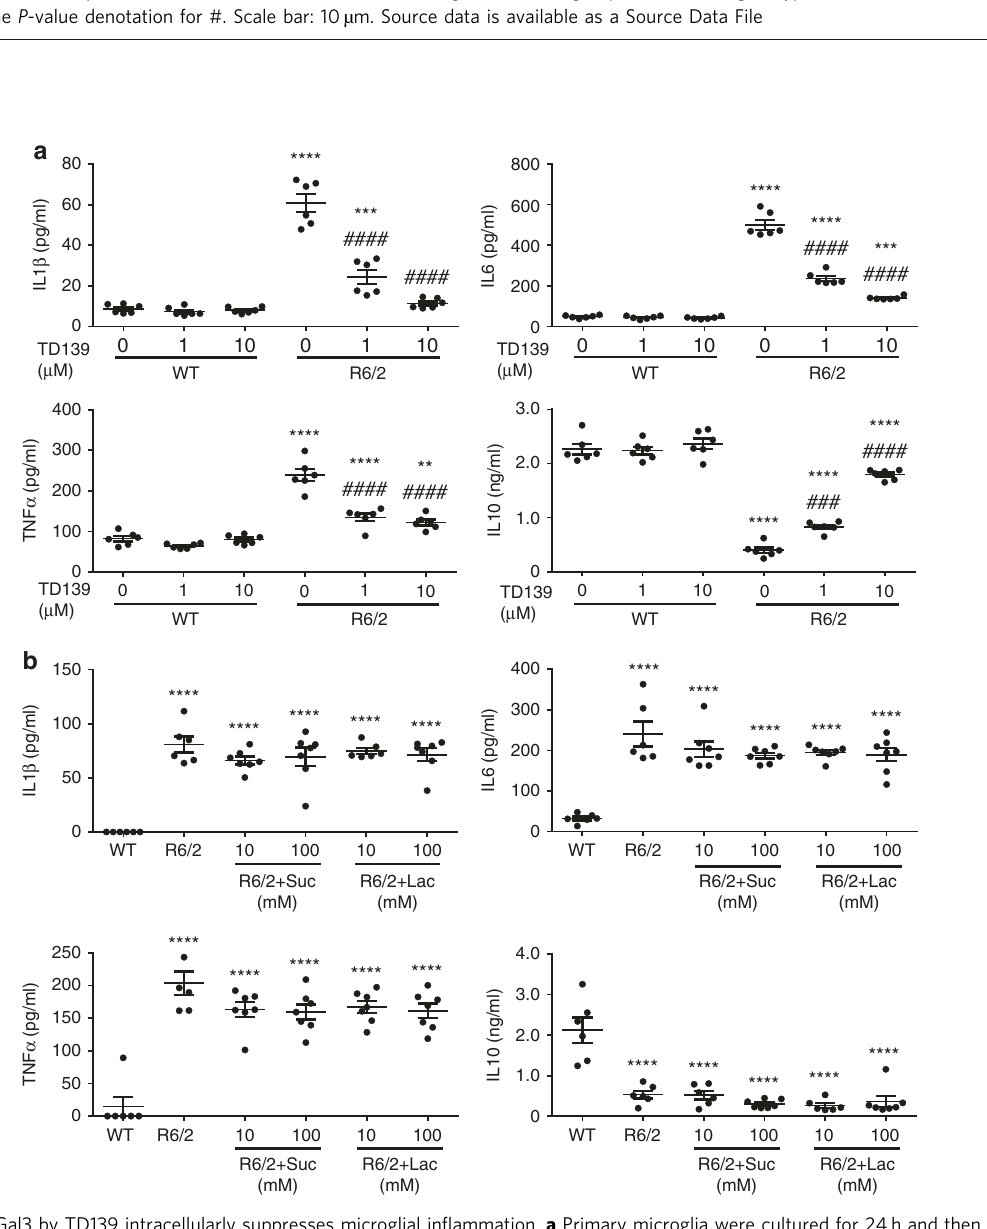
Fig. 4 Suppression of Gal3 reduces the activation of NF κ B and in fl ammation. a , b Primary microglia were infected with the indicated lentiviruses expressing shRNA against Gal3 (i.e., sh Lgals3 ) to knockdown Gal3 or the control lentivirus (sh GFP ), as described in the “ Methods ” section. One week after infection, the levels of Gal3 (green) and nuclear p65 (red) were analyzed by immuno fl uorescence staining. Nuclei were stained with Hoechst. The localization of nuclei in the right-most panels is outlined by dotted lines. The color bars labeled p65 intensity represent the level of p65 intensity, from low to high fl uorescence signals (blue → red, respectively). c An NF κ B transcription factor assay was performed on the nuclear extracts prepared from the indicated primary microglia ( n = 4). d , e ELISA and NO assays were performed on the supernatants collected from the indicated primary microglia to measure the levels of IL1 β , IL6, TNF α , IL10, and nitrite released by the cells. One dot represents the mean value of each sample. The results were analyzed by two-way ANOVA, followed by Tukey ’ s post hoc test. Data are presented as the means ± SEM. *Speci fi c comparison between WT and R6/2 cells infected with the same lentivirus; #Speci fi c comparison between the sh GFP -infected and sh Lgals3 -infected groups of the same genotype; * P < 0.05, ** P < 0.01, *** P < 0.001,